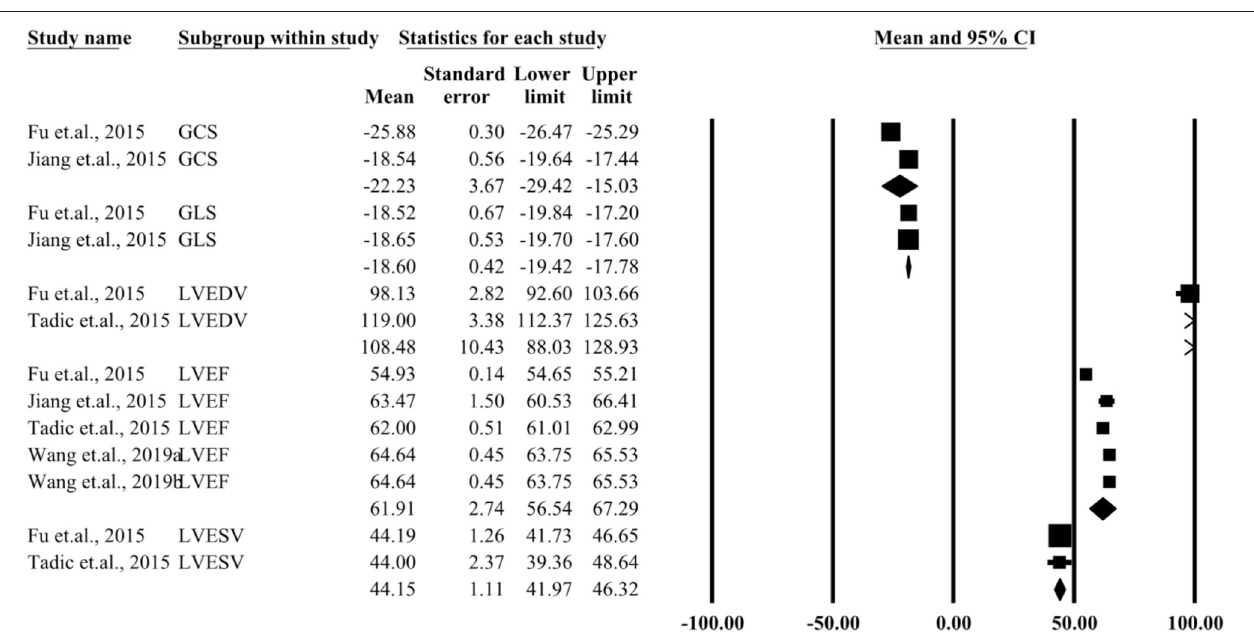
Frontiers in Cardiovascular Medicine |